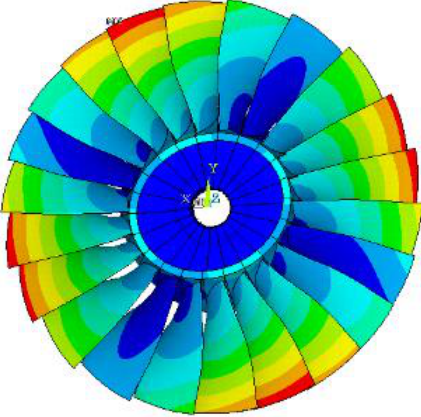
Figure 1. Rotor67 bladed disk two-nodal diameter mode.